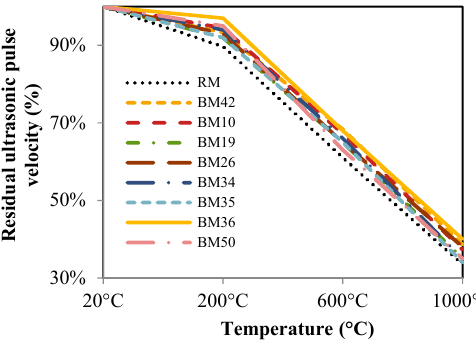
Figure 15. Residual ultrasonic pulse velocity.